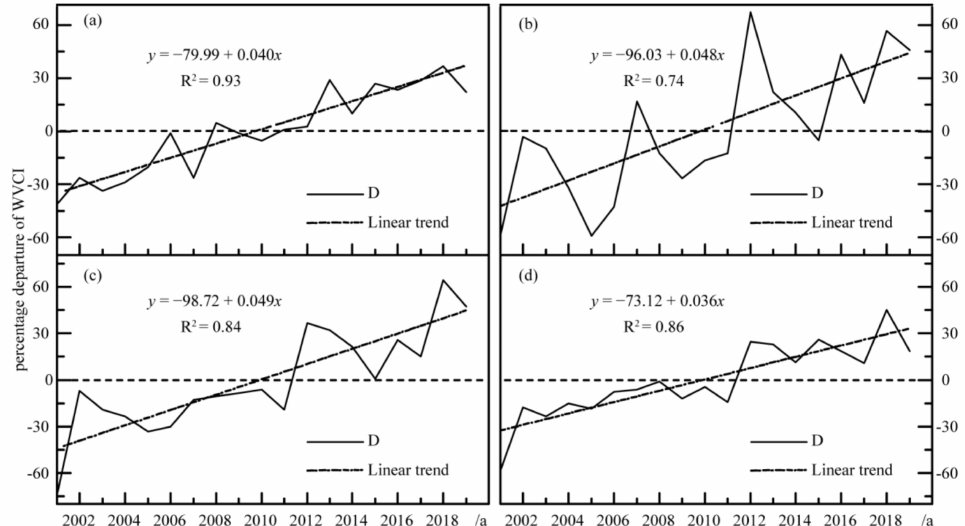
Figure 7. Temporal variation in D time series for the ( a ) forest, ( b ) shrub, ( c ) grassland and ( d ) farmland in the Loess Plateau from 2001 to 2019. ‘D’ represents the departure percentage of